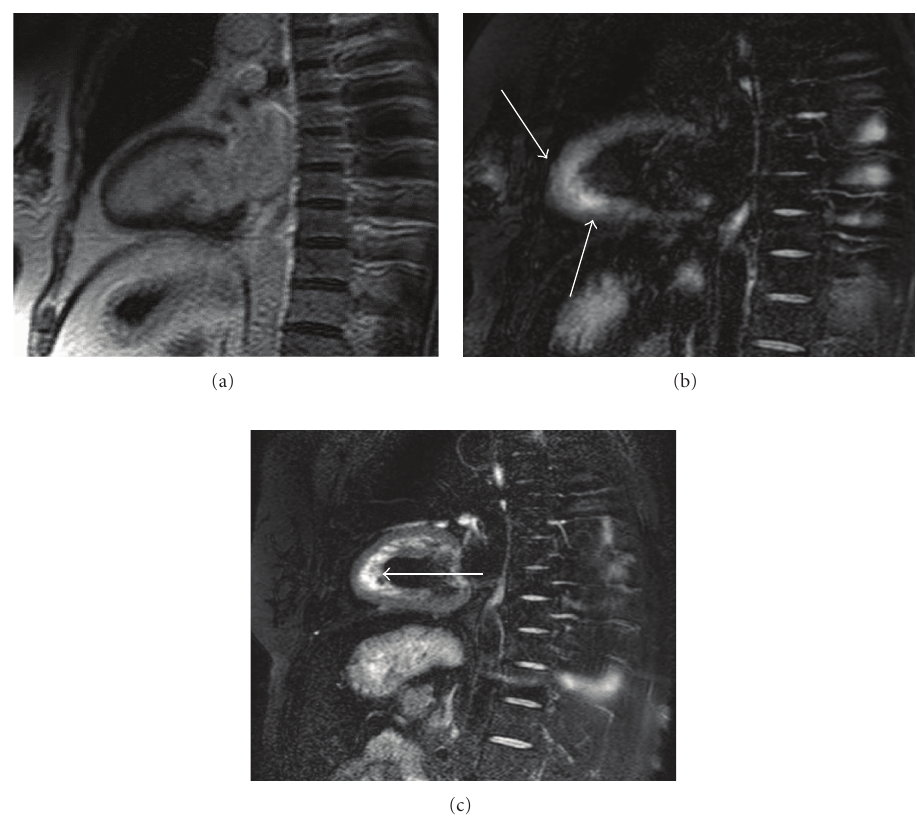
Figure 9: 55-year-old female with takotsubo cardiomyopathy. Long-axis delayed enhancement (a) shows no myocardial scarring of the apical myocardium, whereas the T2-weighted MRI (b) shows circumferential myocardial edema at the apical and midventricular regions (arrows). The T2-weighted MRI at its remission (c) shows no myocardial edema. The flow artifact is seen in the apical cavity (arrow), due to the insu ffi cient blood signal suppression by black-blood